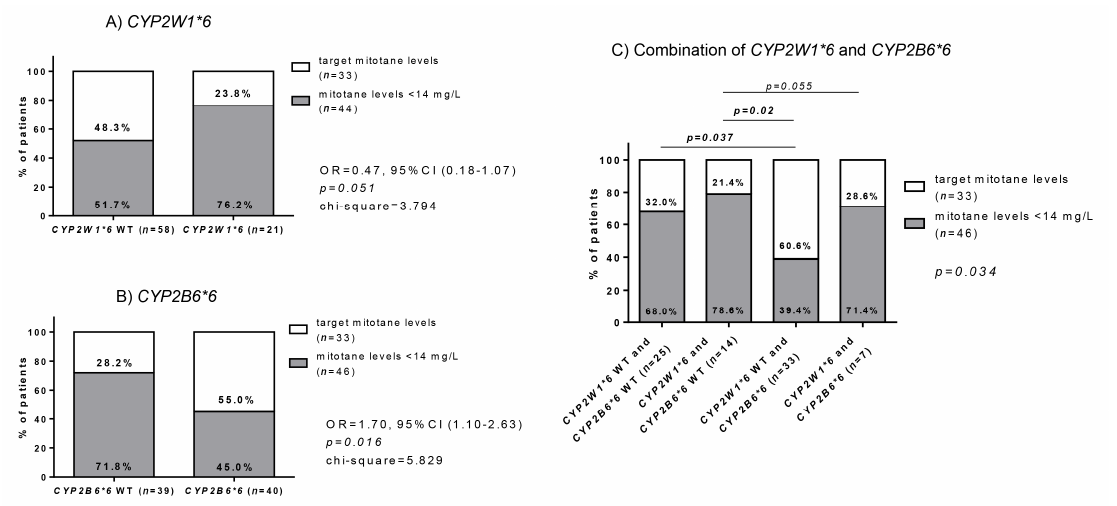
Figure 2. Correlation between the presence of CYP2W1*6 and/or CYP2B*6 SNPs with the achievement of mitotane target levels in group B ( n = 79). ( A ) Relationship between presence of CYP2W1*6 and achievement of mitotane target levels. ( B ) Relationship between presence of CYP2B6*6 and achievement of mitotane target levels ( C ) Relationship with the achievement of target mitotane levels based on the combination of the two SNPs. Statistical analysis was performed by Chi-square test on absolute